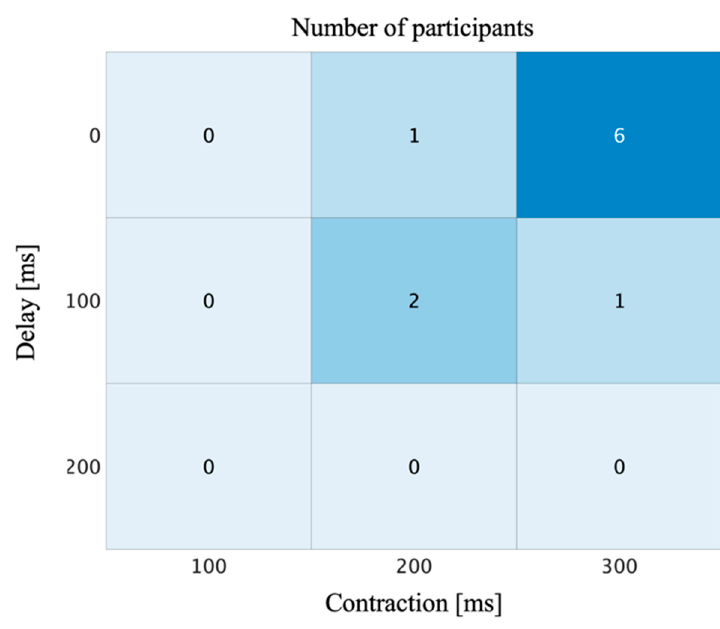
Figure 5 . Heat map showing the distribution of effective parameters.